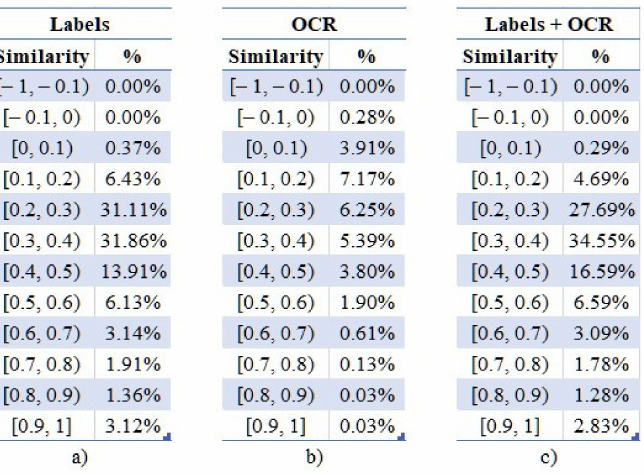
Figure 9. The distribution of cosine similarity values ( a – c ) per type of latent